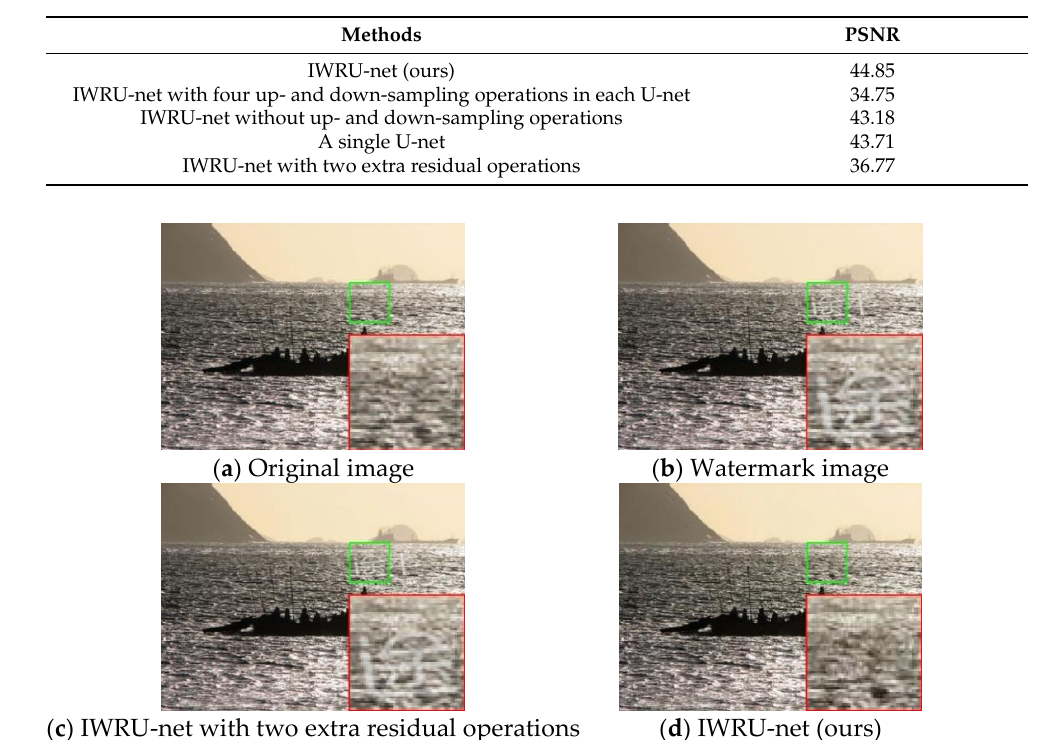
Figure 2. Visualization of different methods of watermark removal on an image from the